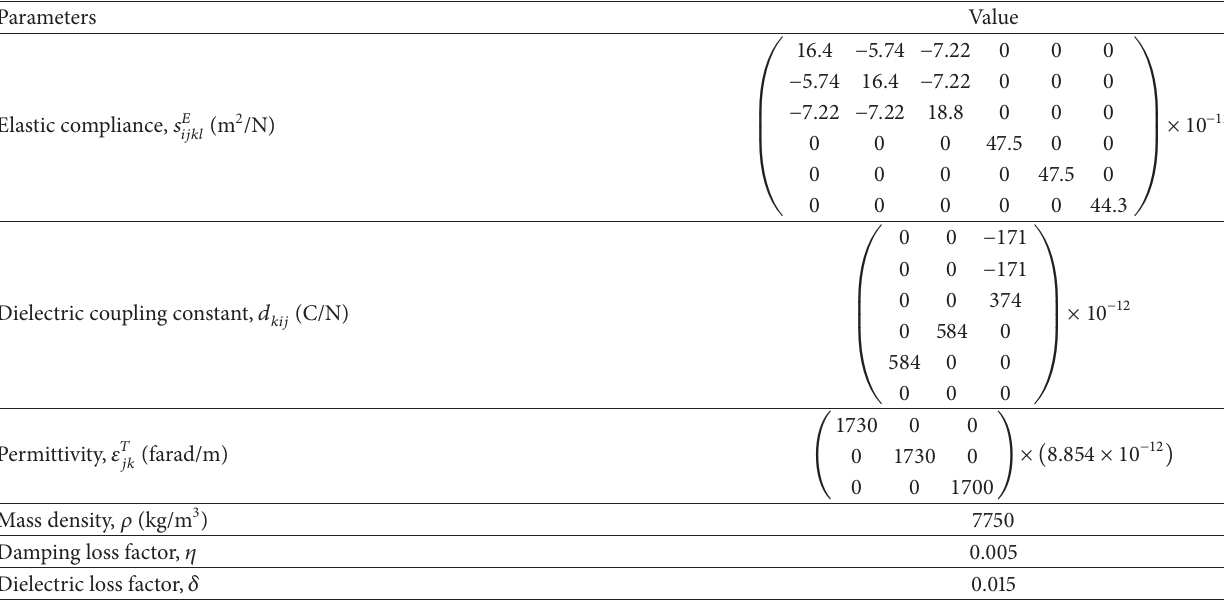
Table 2: Properties of PZT-5A patch [23].